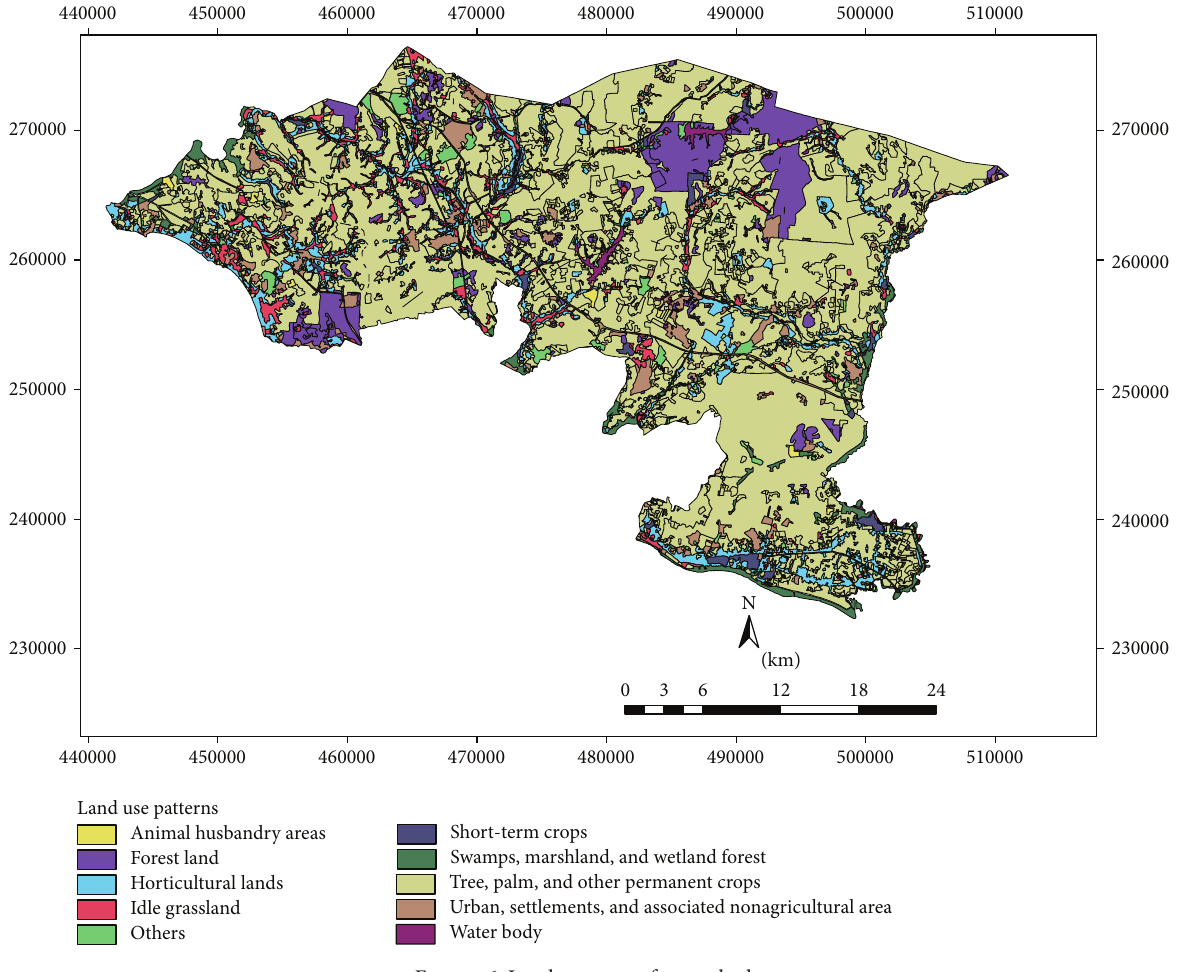
Figure 6: Land use map of